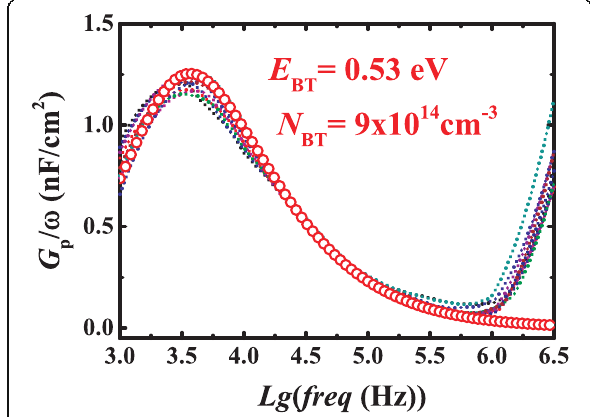
Fig. 6 Experimental ( dotted lines ) and fitted ( red circles ) Gp / ω curves with gate biased in the deep depletion